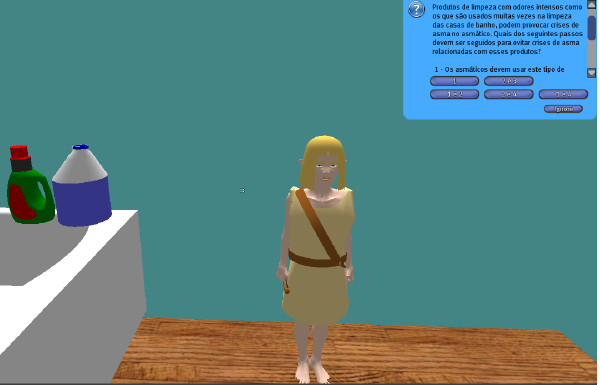
Figure 4. Cleansing products in the bathroom with strong odors (such as cleaners, paints, adhe- sives, pesticides, air fresheners, or cosmetics)?”. 9. Carpets were provided on the floor. This occur- rence further related to dust mites and the ques- tion:“What type of floor covering is